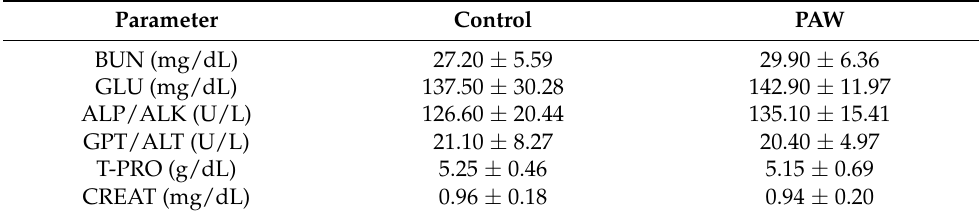
Table 4. Blood biochemical parameters.